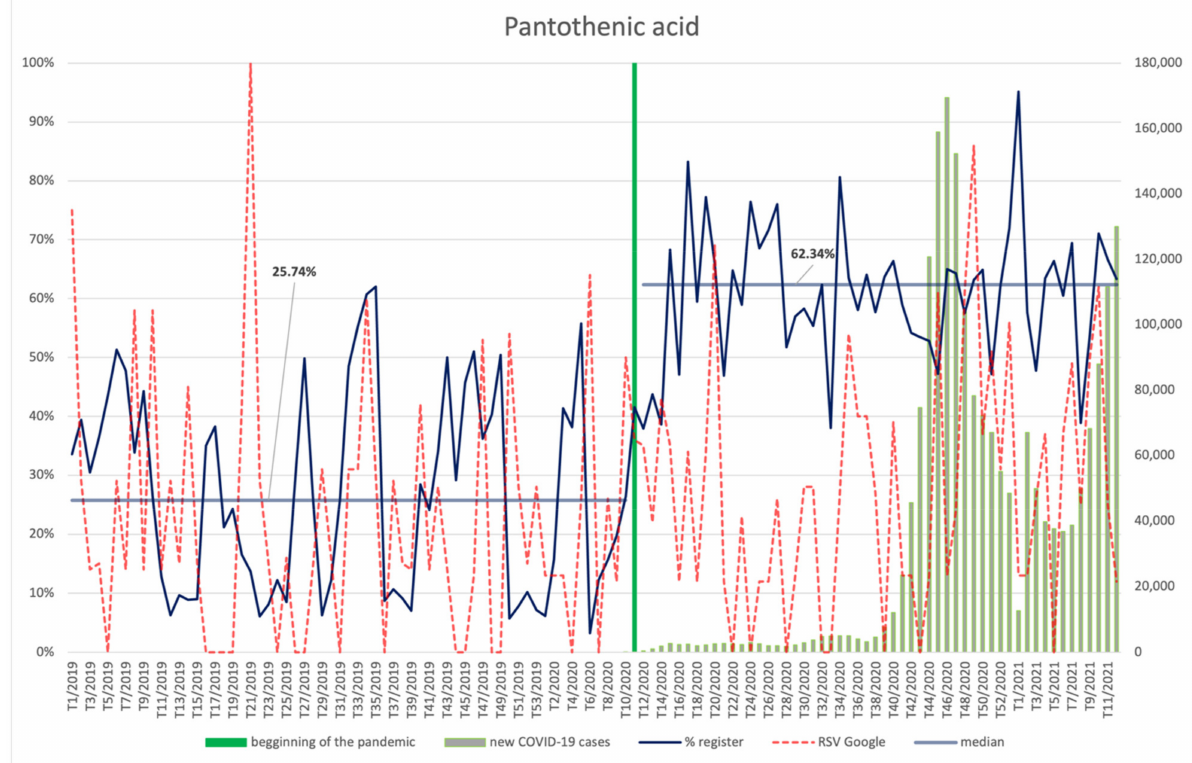
Figure 15. Comparison between the number of new registrations of products containing pantothenic acid, the number of COVID-19 cases, and the frequency of search for information on the ingredient in the Google